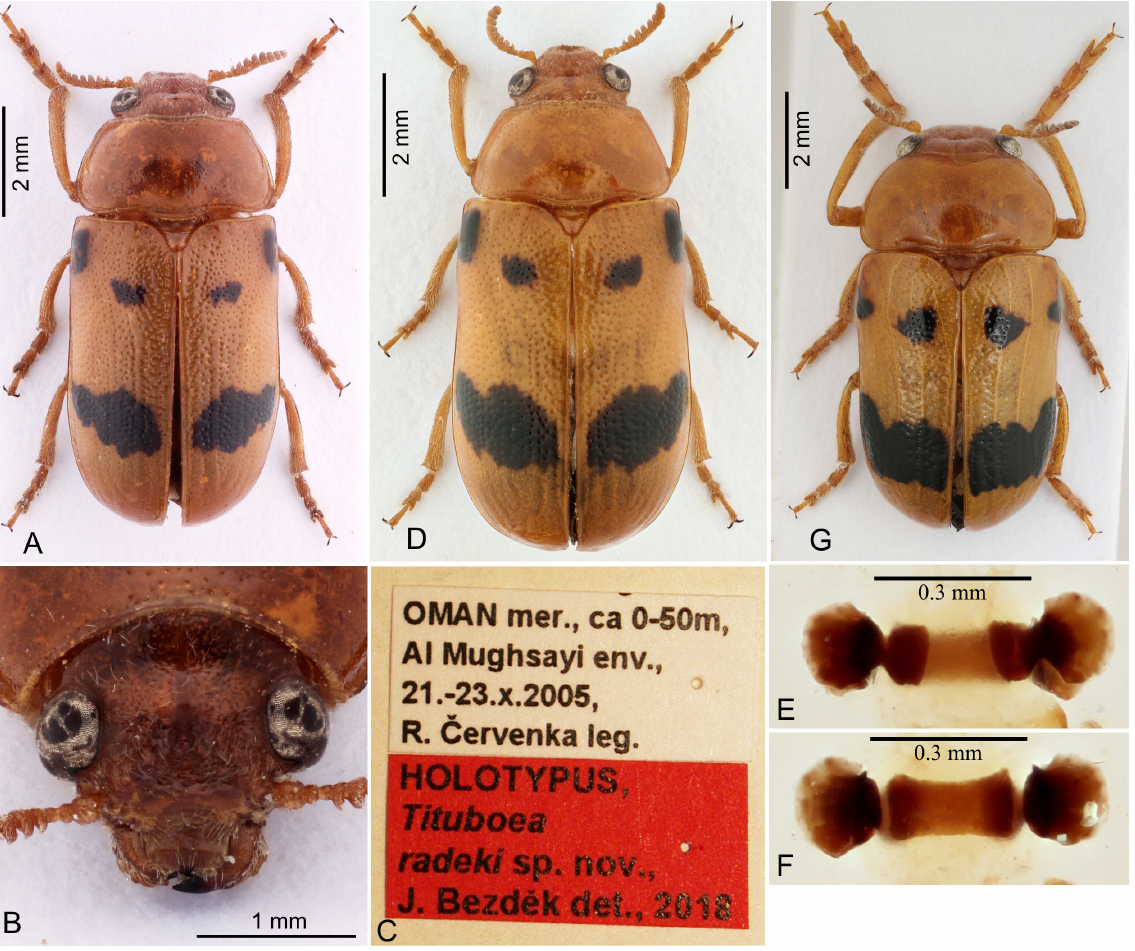
Fig. 9. A – C , E – F . Holotype of Tituboea radeki Bezděk sp. nov., ♂, 8.1 mm (NMPC). D . Paratype of Tituboea radeki Bezděk sp. nov., ♀, 7.4 mm (LSCP). A . Dorsal view. B . Head. C . Labels. D . Dorsal view. E . Kotpresse, ventral sclerites. F . Kotpresse, dorsal sclerites. G . T. arabica (Olivier, 1808), ♂, 8.0 mm